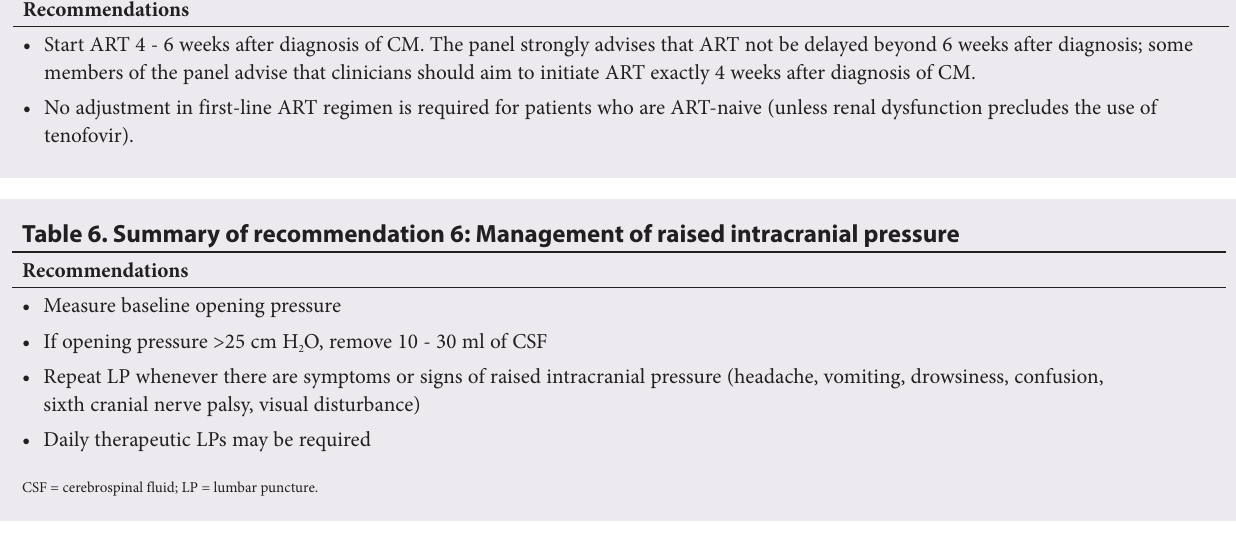
Table 5. Summary of recommendation 5: Timing of ART among patients with CM Recommendations